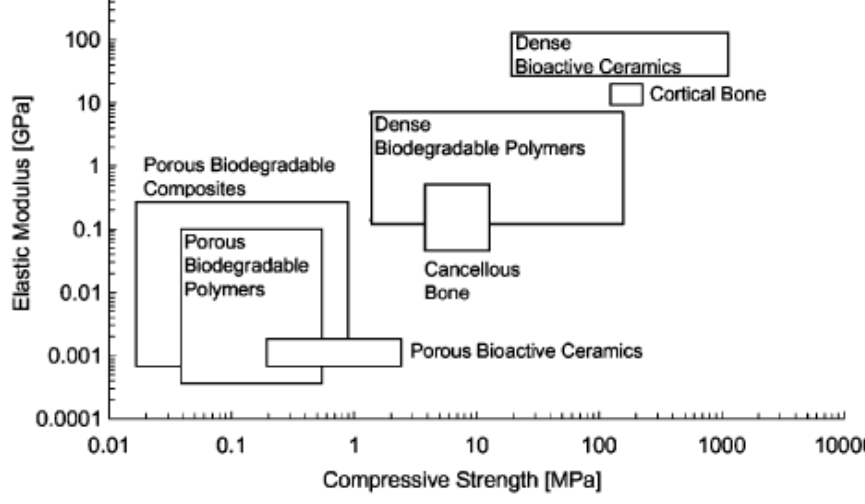
Figure 13. Elastic modulus vs. compressive strength values of biodegradable polymers, bioactive ceramics and composites after ref. [37]. Porosities of scaffolds are considered to be >75% and mostly interconnected. Dense polymers can match cancellous bone properties and approach cortical bone properties. Moreover, the bioactive ceramics region is close to cortical bone. Porous scaffolds, however, are at least one order of magnitude weaker than cancellous bone and orders of magnitude weaker than cortical bone. Figure reproduced with permission of